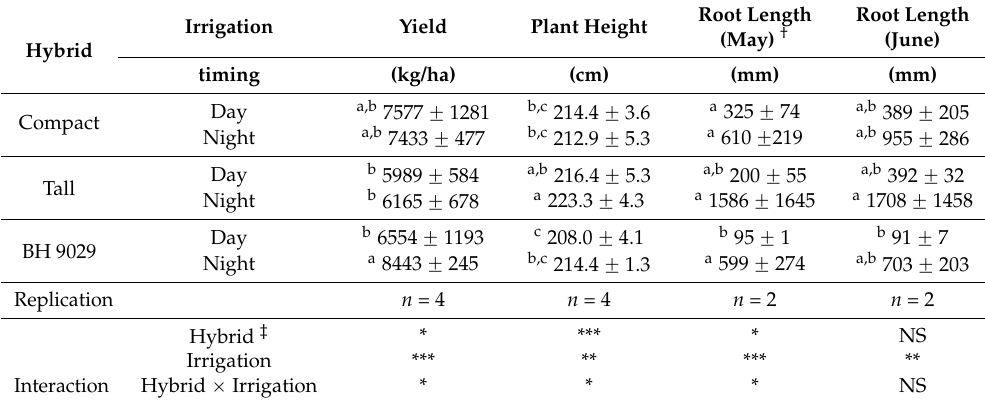
Table 2. Grain yield, plant height and root length of three corn hybrids comparing drip irrigation delivery in day-time vs.